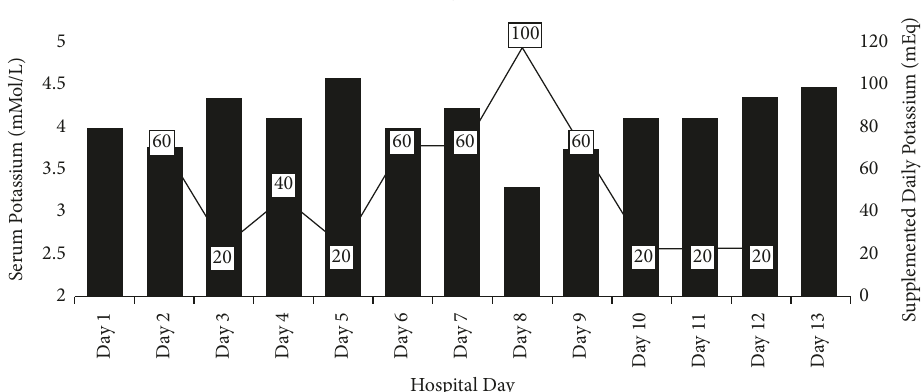
Figure 3: Serum potassium and potassium supplementation.